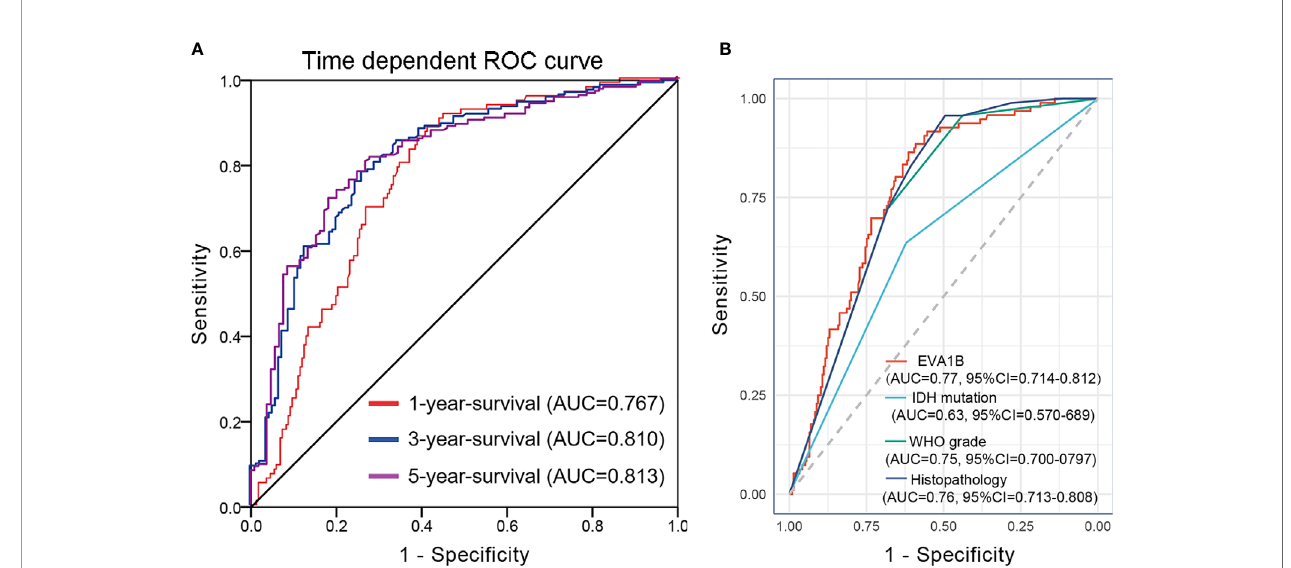
FIGURE 4 | Predictive power for prognosis with EVA1B expression by ROC curve analysis. (A) ROC curves showed that the AUC of EVA1B for predicting 1-, 3- and 5-years survival of patients is 0.767, 0.810, and 0.813, respectively. (B) The prediction performance of EVA1B protein is higher than IDH mutation, WHO grade, and